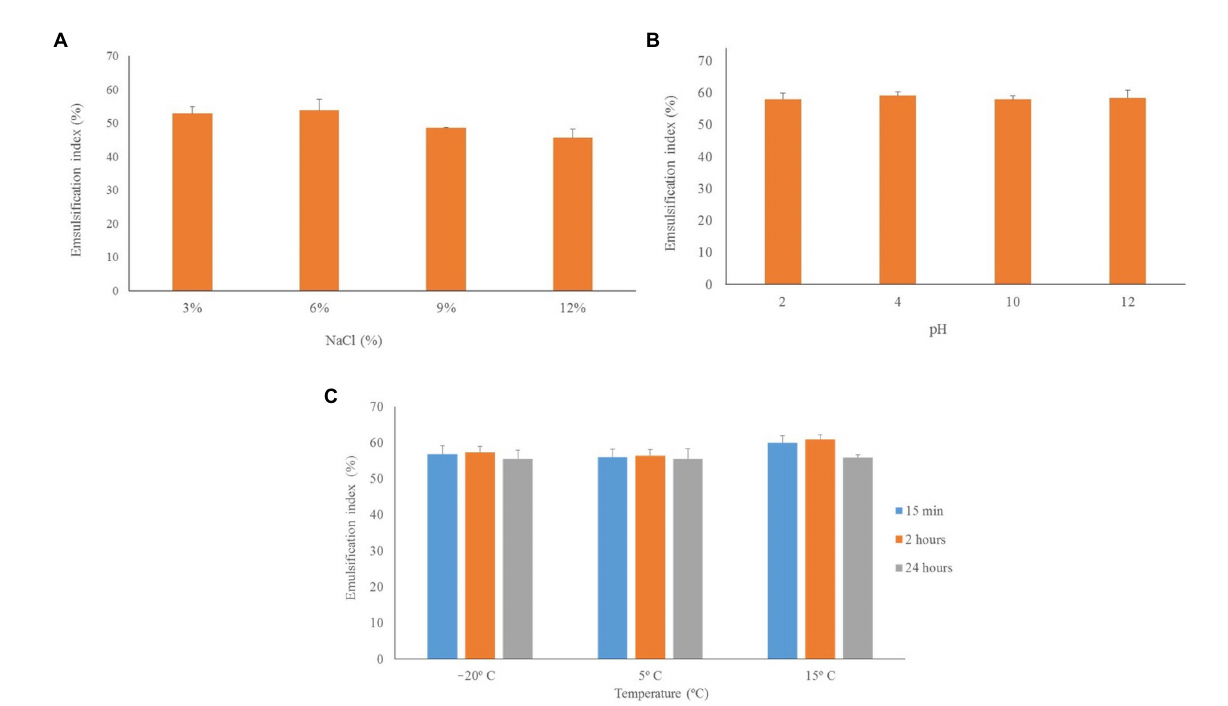
FIGURE 6 Stability of the bioemulsifier produced by IPAC21 under different salinity, pH and temperature conditions. (A) NaCl concentrations of 3, 6, 9 and 12%. (B) pH of 2, 4, 10, 12. (C) Temperatures of − 20 ° C, 5 ° C and 15 °